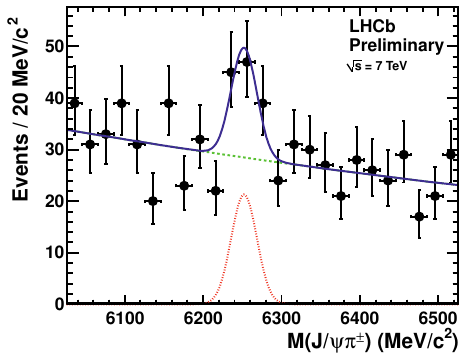
Figure 3. Invariant mass distribution for B + c → J /ψπ + candidates.